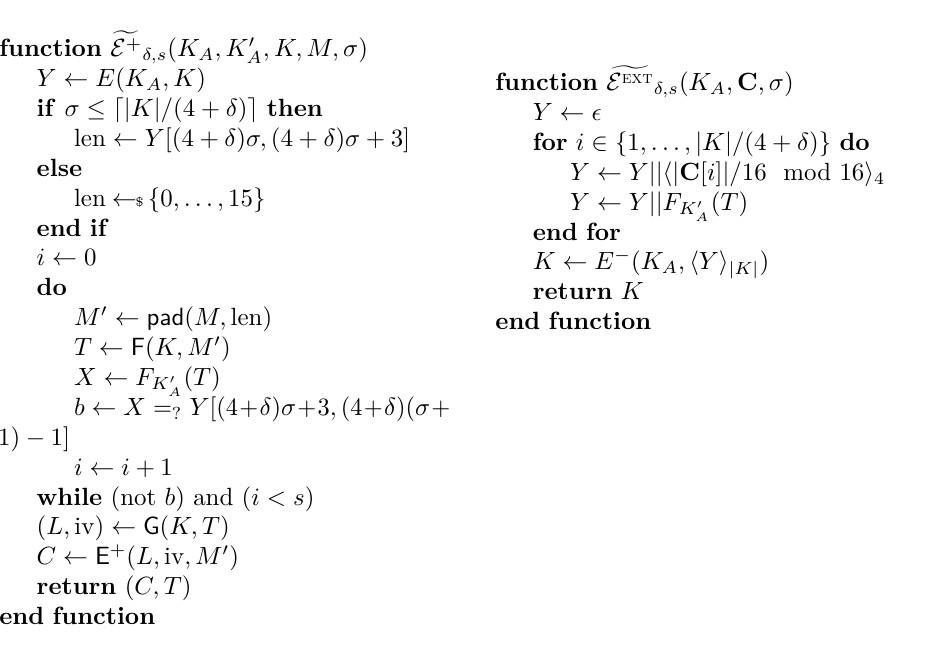
Algorithm 5.2 Pseudocode of the updated subversion attack f E + δ,s . We use the same notation as in Algorithm 5.1, and F a PRF with range { 0 , 1 } δ . Ciphertexts are denoted ( C, T ) where T refers to the authentication